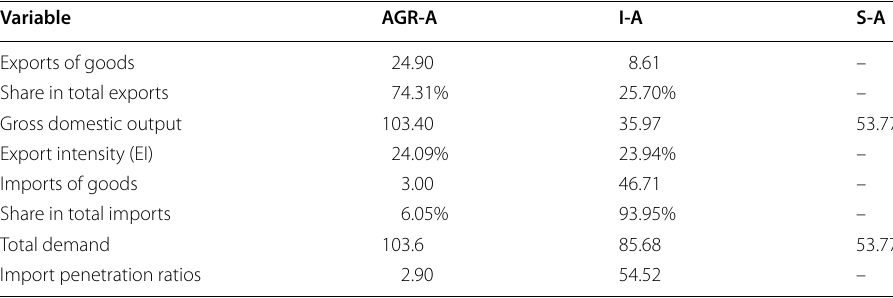
Table 7 Structure of trade values in billion ETB. Source: author’s computation using GAMS Variable